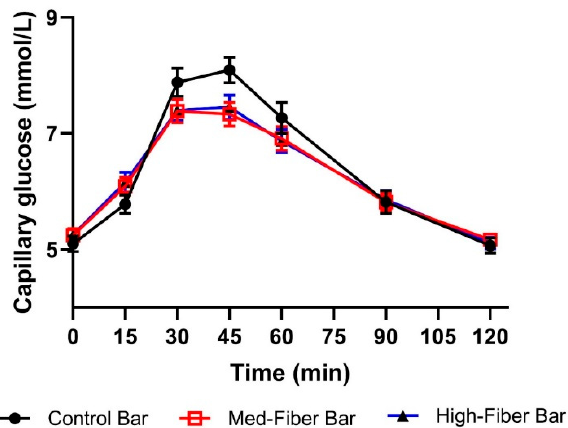
Figure 3. Post-prandial glycemic response (capillary glucose) in healthy adults. Data are mean ± SEM. n = 38.